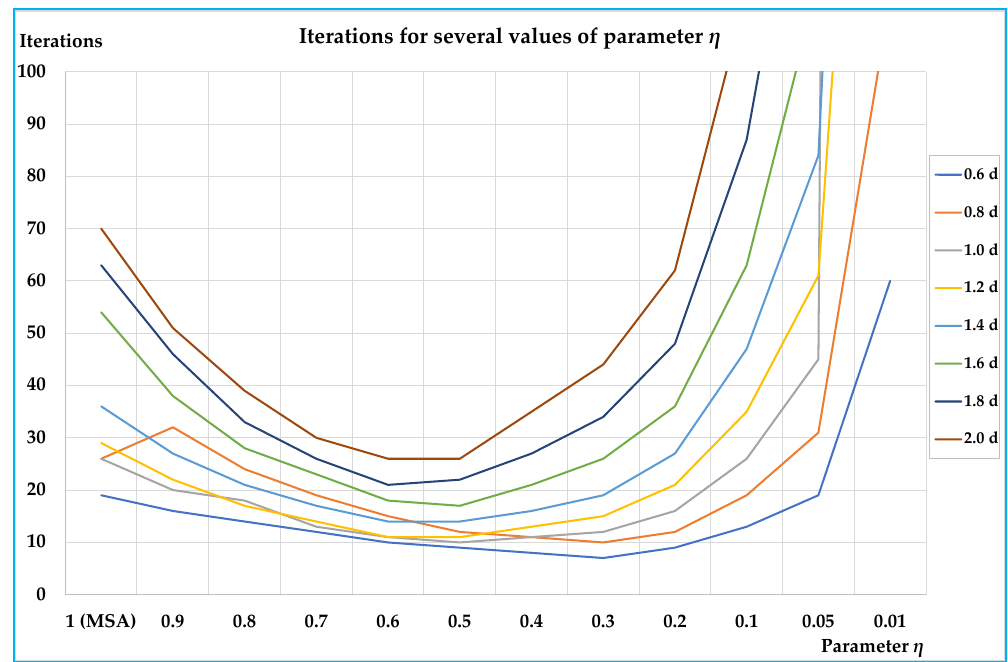
Figure 8. Results on the rural real-scale network.